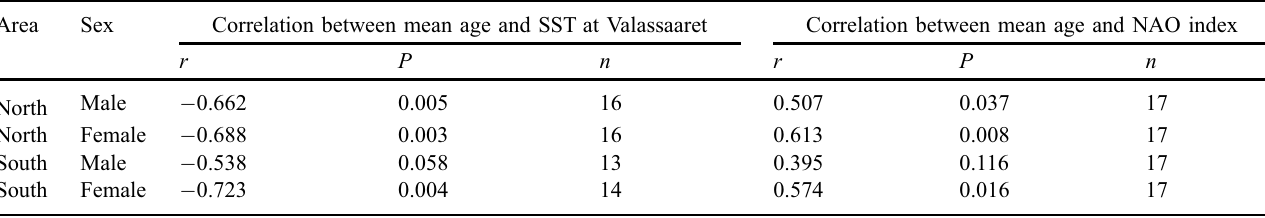
Number of years = n . Signi fi cance = P. The SST in June was measured in the third sea year of the year class and the NAO in June to August was measured in the second sea year of the year class.